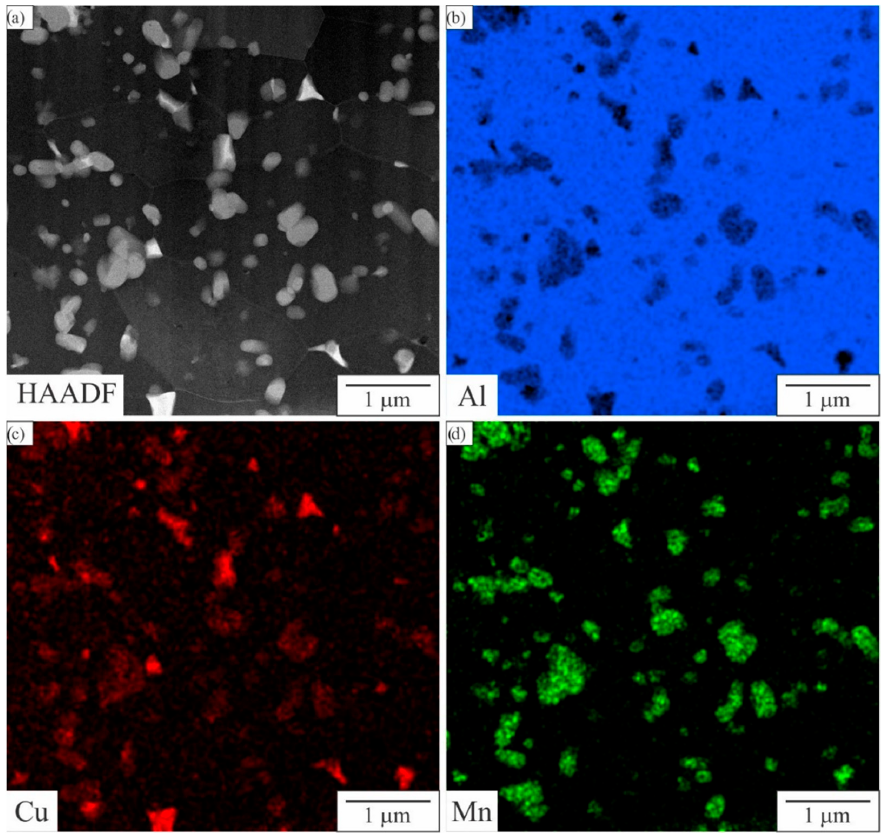
Figure 9. Microstructure and elemental mapping of sample FSP950 in the NZ. ( a ) HAADF STEM micrograph, ( b ) distribution of Al, ( c ) distribution of Cu, and ( d ) distribution of Mn extracted from EDS.